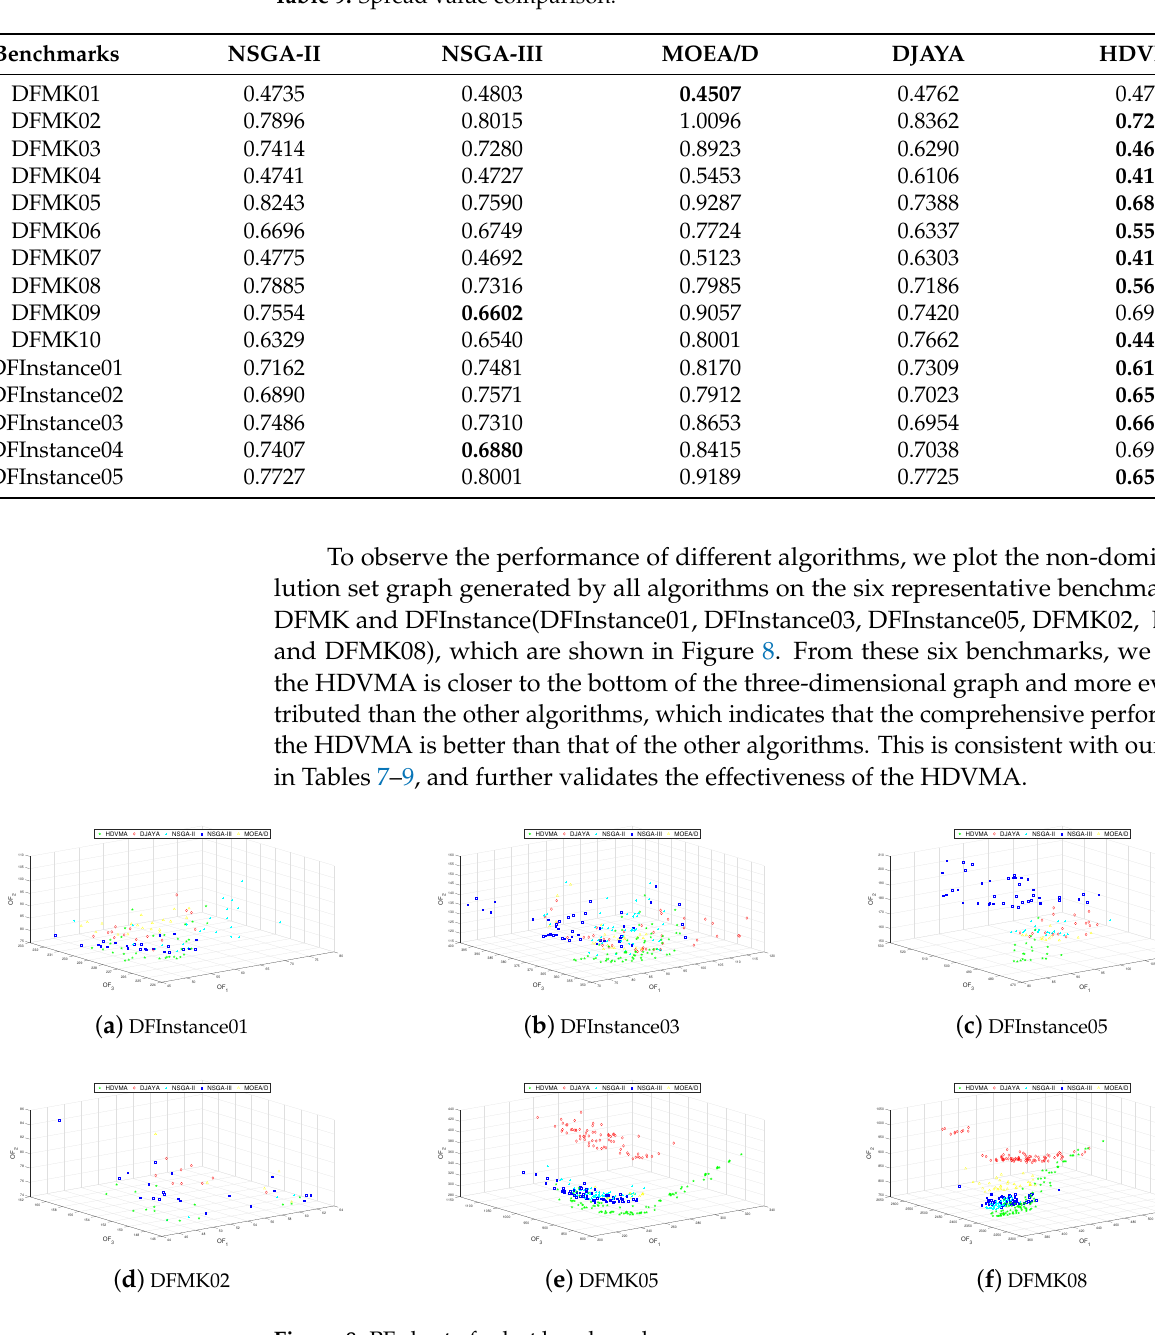
Table 9. Spread value comparison.